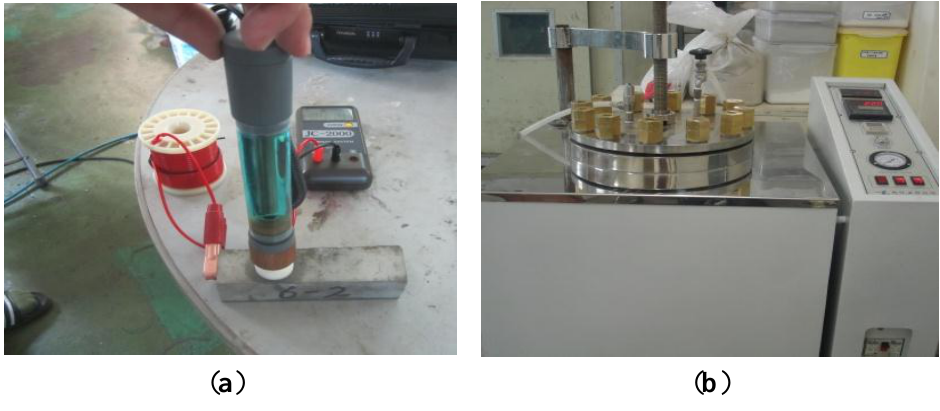
Figure 4. Temperature profile of autoclave-accelerated corrosion.